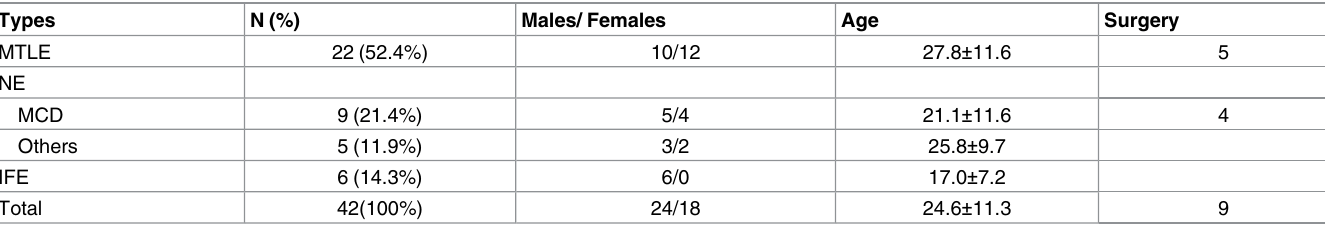
Table 1. Types of focal epilepsy.